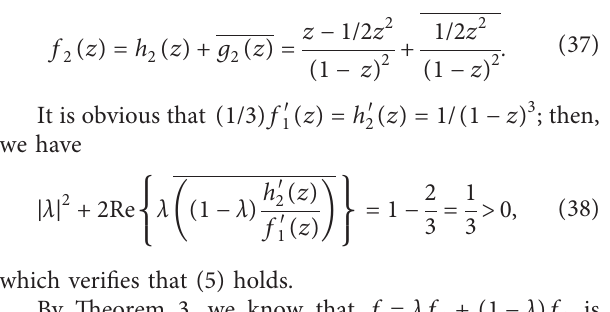
,f , and f . (a) f 1 2